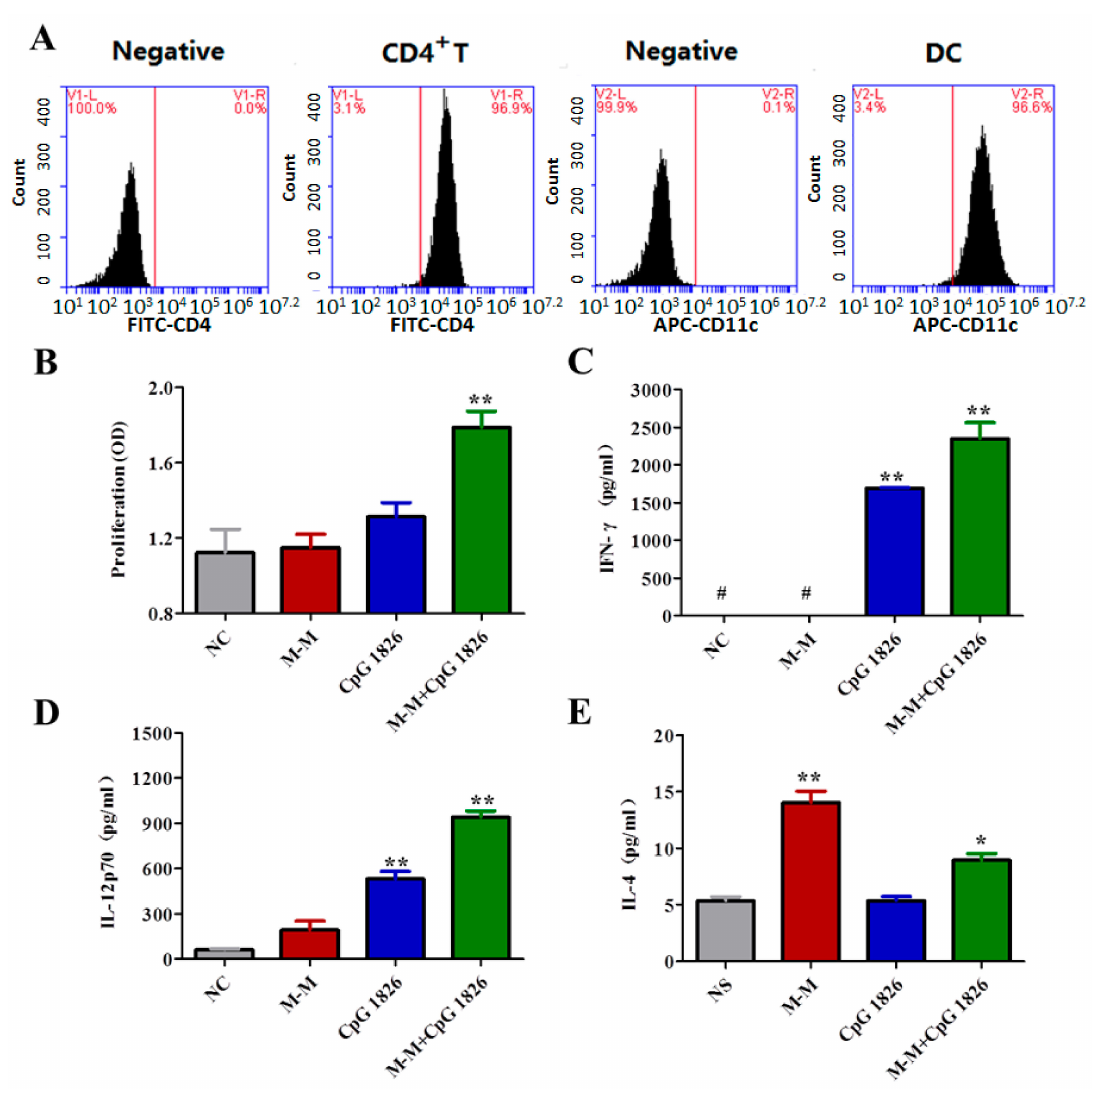
Figure 4. CD4 + T cell activation is enhanced by a co-culture with BMDCs stimulated with the combination of M-M and CpG 1826 in vitro. ( A ) The isolation of CD4 + T cells from the spleen samples from immunized mice and BMDCs from untreated mice. The CD4 + T cell and DC percentage was analyzed by flow cytometry. The purity of the CD4 + T cells was 96.9%. The purity of the DCs was 96.6%. ( B ) M-M and CpG 1826 synergistically increased the proliferation of co-cultured CD4 + T cells and DCs. ( C – E ) The production of IFN- γ , IL-12p70, and IL-4 in the CD4 + T cells cocultured with DCs, as detected by ELISA. The CD4 T cells were co-cultured with the DCs at a ratio of 50:1. All the experiments were repeated three times, and all the data are expressed as the mean ± SD ( n = 3). # represents production <25 pg/mL. * p < 0.05, ** p < 0.01 vs. NC